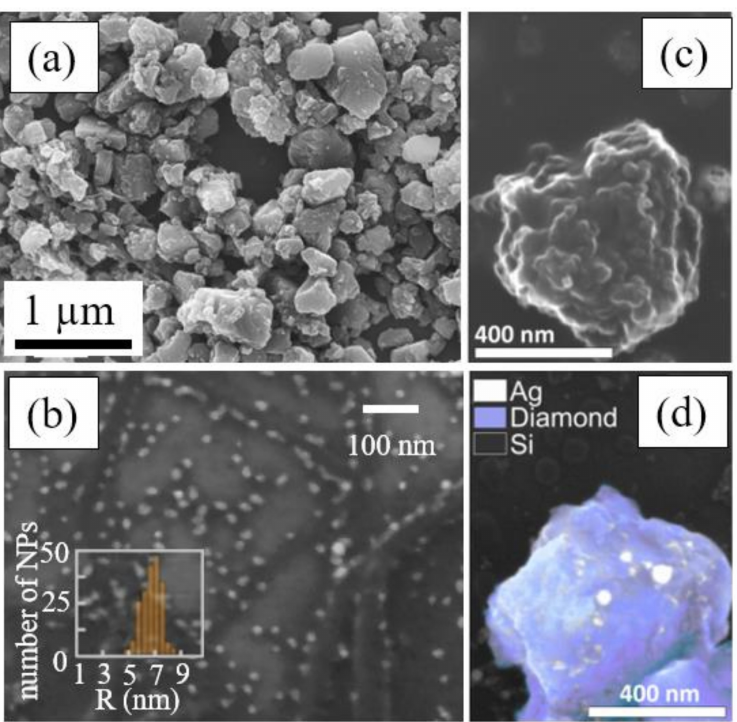
Figure 9. Silver-NP capped nanodiamonds produced via ns-laser ablation of bulk silver sample immersed into nanodiamond suspension in water (adapted from [17]): Top-view SEM images of nanodiamonds ( a ) and silver nanoparticles ( b ), separate nanodiamonds completely ( c ) or partially ( d ) capped by silver